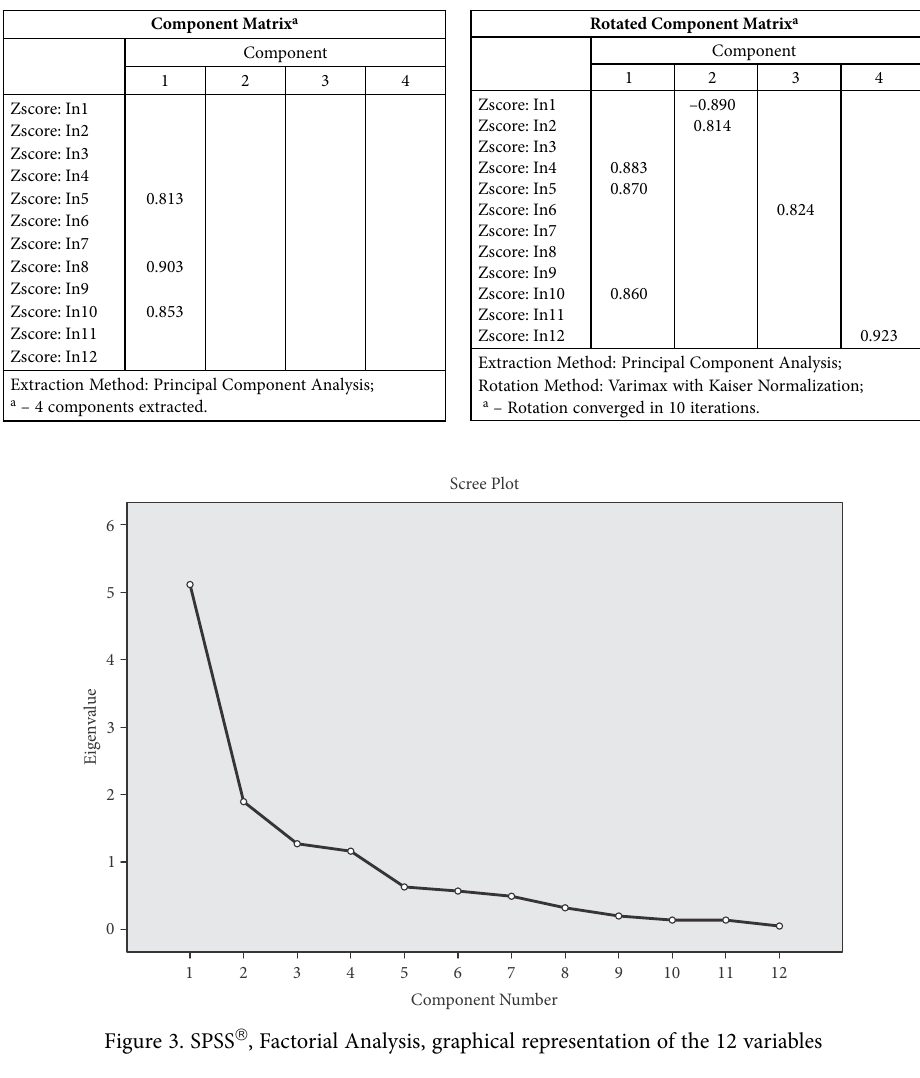
Table 6. SPSS  , Matrix of components and component matrix after rotation